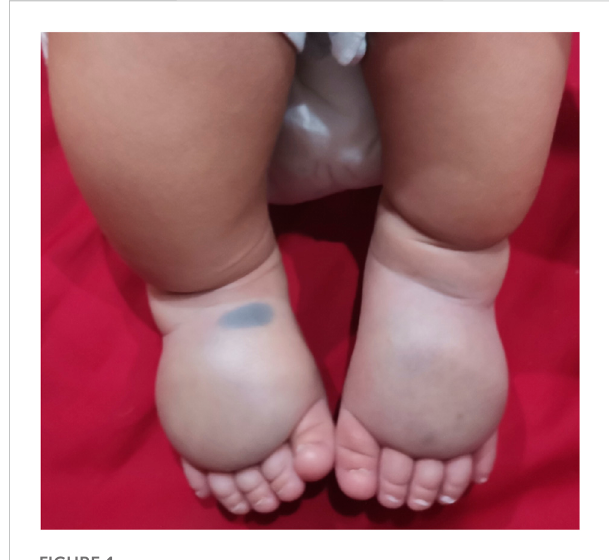
FIGURE 1 Congenitallymphedemaofthelowerextremitiesoftheproband.